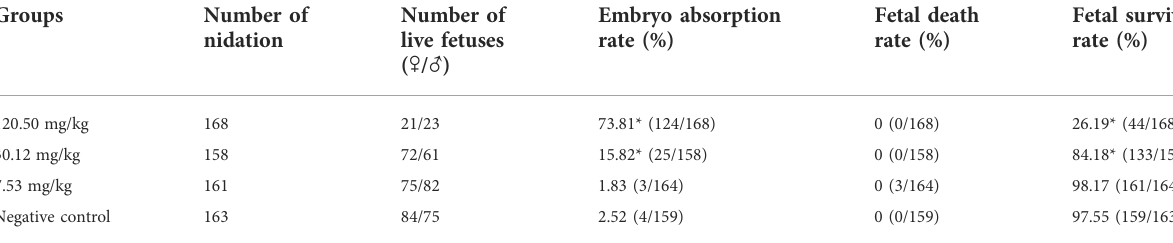
TABLE 4 Effect of MPTA on the survival rate of rat embryos (n = 12). Groups